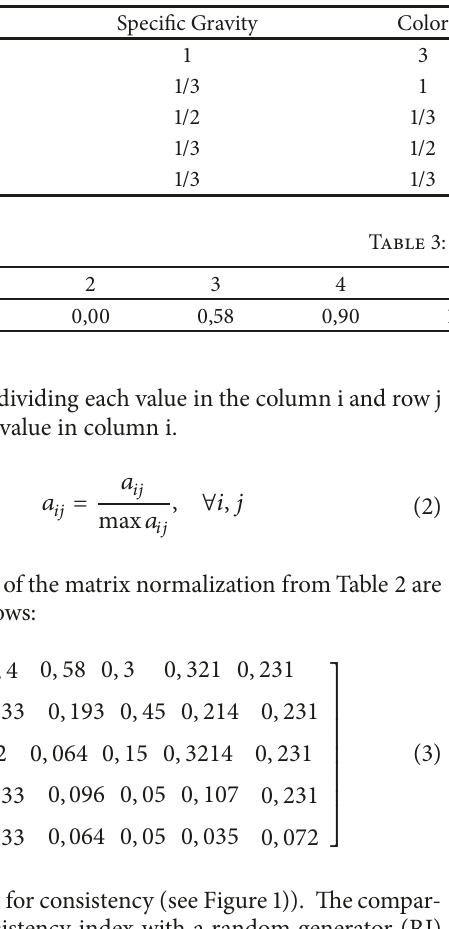
Table 2: Comparison of criteria, as the weighted value of each criterion.